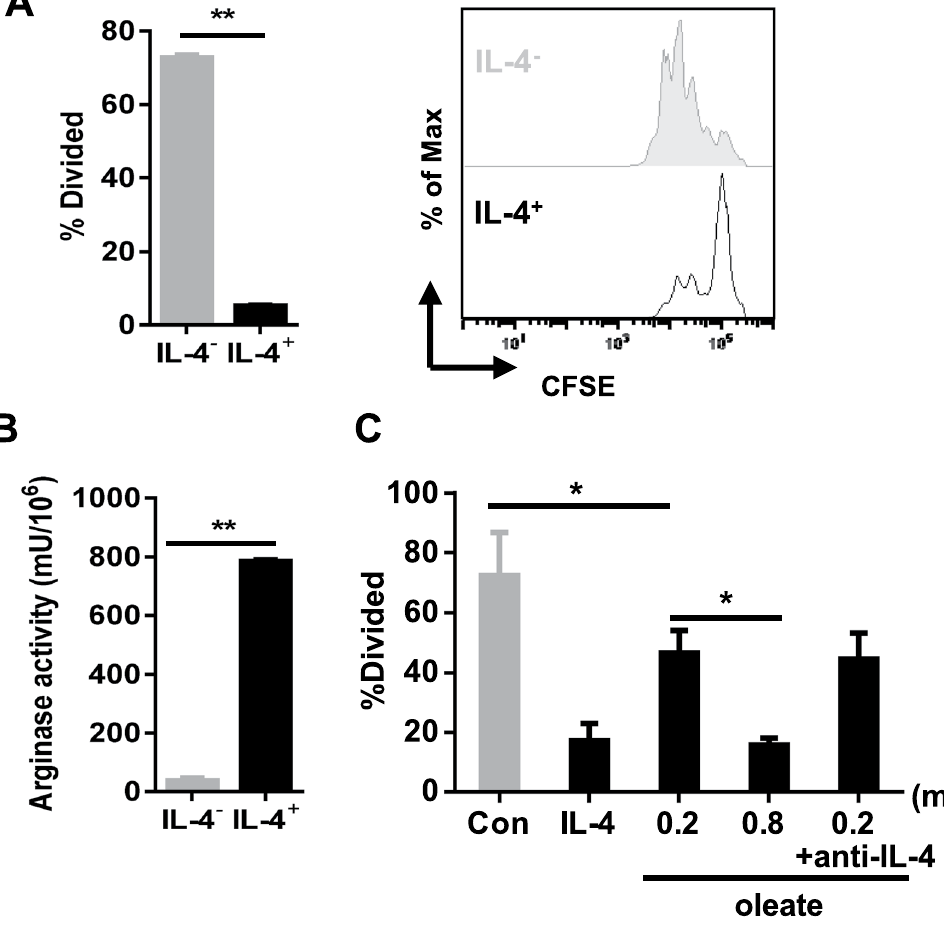
Figure 1. Sodium oleate is sufficient to induce a regulatory phenotype in MSC-2 cells. MSC-2 cells were incubated in the presence or absence of IL-4 (100 ng/ml) for four days as indicated, followed by the analysis of their inhibitory potency: Purified CD4 + T cells were co-cultured with MSC-2 cells in the presence or absence of IL-4 in a ratio of 1:5. T cell proliferation was analyzed by CFSE staining after 72 h ( A ). After a four-day culture of MSC-2 cells in the presence or absence of IL-4 (100 ng/ml), arginase activity was determined ( B ). Purified CD4 + T cells were co-cultured with MSC-2 cells in the presence or absence of IL-4, sodium oleate (0.2 mM) or a neutralizing IL-4 antibody (10 µ g/ml) as indicated. T cell proliferation was analyzed by CFSE staining after 72 h ( C ). Shown is the mean ± SD from two to three independent experiments. * p ≤ 0.05; ** p ≤ Diacylglyercol acyltransferase-dependent lipid droplets formation controls the effect of sodium oleate on MSC-2 cells. While tumor cells are capable of de novo fatty acid synthesis, tumor stroma cells prefer the uptake of exogenous FFA 20 . Acetyl-CoA carboxylase (ACC) catalyzes the irreversible carbox- ylation of acetyl-CoA to malonyl-CoA, which is the most important element for de novo fatty acid synthesis. Here the specific inhibitor of ACC, 5-(tetradecyloxy)-2-furoic acid (TOFA), served to investigate the role of de novo fatty acids with regard to the sodium oleate-induced suppressive effect. The presence of TOFA reduced the sodium oleate-induced lipid droplets formation, paralleled by a modest reduction of the inhibitory function of these MSC-2 cells (Fig. 5A/B). These results exclude an exclusive role of de novo fatty acid synthesis in mediating the suppressive capacity of sodium oleate-induced MSC-2 cells. The enzymes directly connected to the lipid droplets accumulation are the diacylglycerol acyltransferases (DGAT) 1 and DGAT2. Harris et al . proved that the accumulation of lipid droplets in adipocytes was only diminished in DGAT1 and DGAT2 double knockout (KO) but not in single KO mice 21 , indicating a potent compensatory mechanism between the two enzymes. In line, our own data demonstrated that only the combined inhibition of both DGAT by iDGAT (400 nM) sufficed to abolish sodium oleate-induced lipid droplets formation in MSC-2 cells (Fig. 5C/D). In parallel, with lipid droplets formation, the presence of iDGAT impaired the inhibitory function of these cells (Fig. 5E/F) as well as the NO production in the co-culture supernatants (Fig. 5G). These results suggest that not only the presence of distinct free fatty acids in the cytoplasm but also the lipid droplets formation itself mediates the regulatory phenotype of MSC-2 cells.